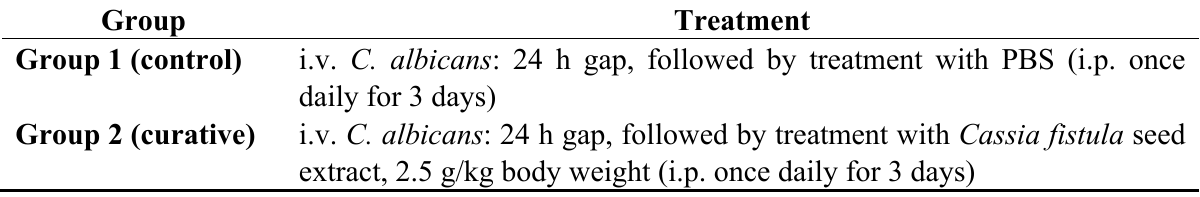
Table 2. Details of experimental